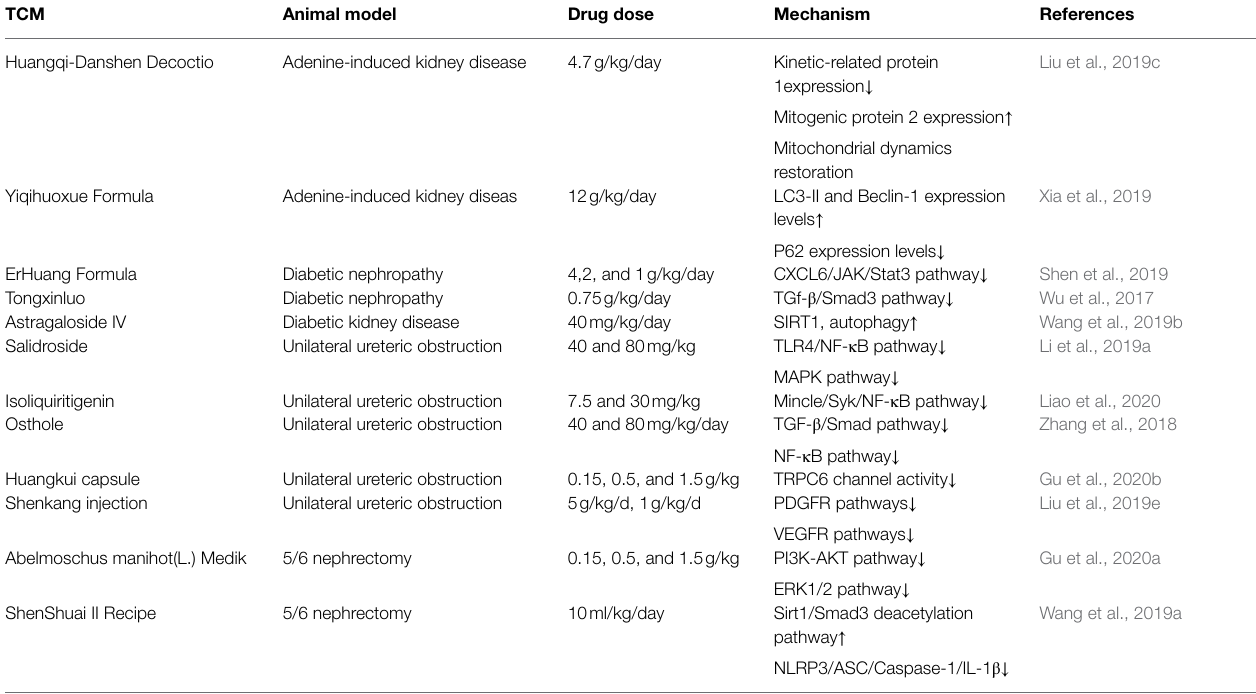
TABLE 3 | Mechanistic studies of Traditional Chinese Medicine (TCM) in the treatment of renal